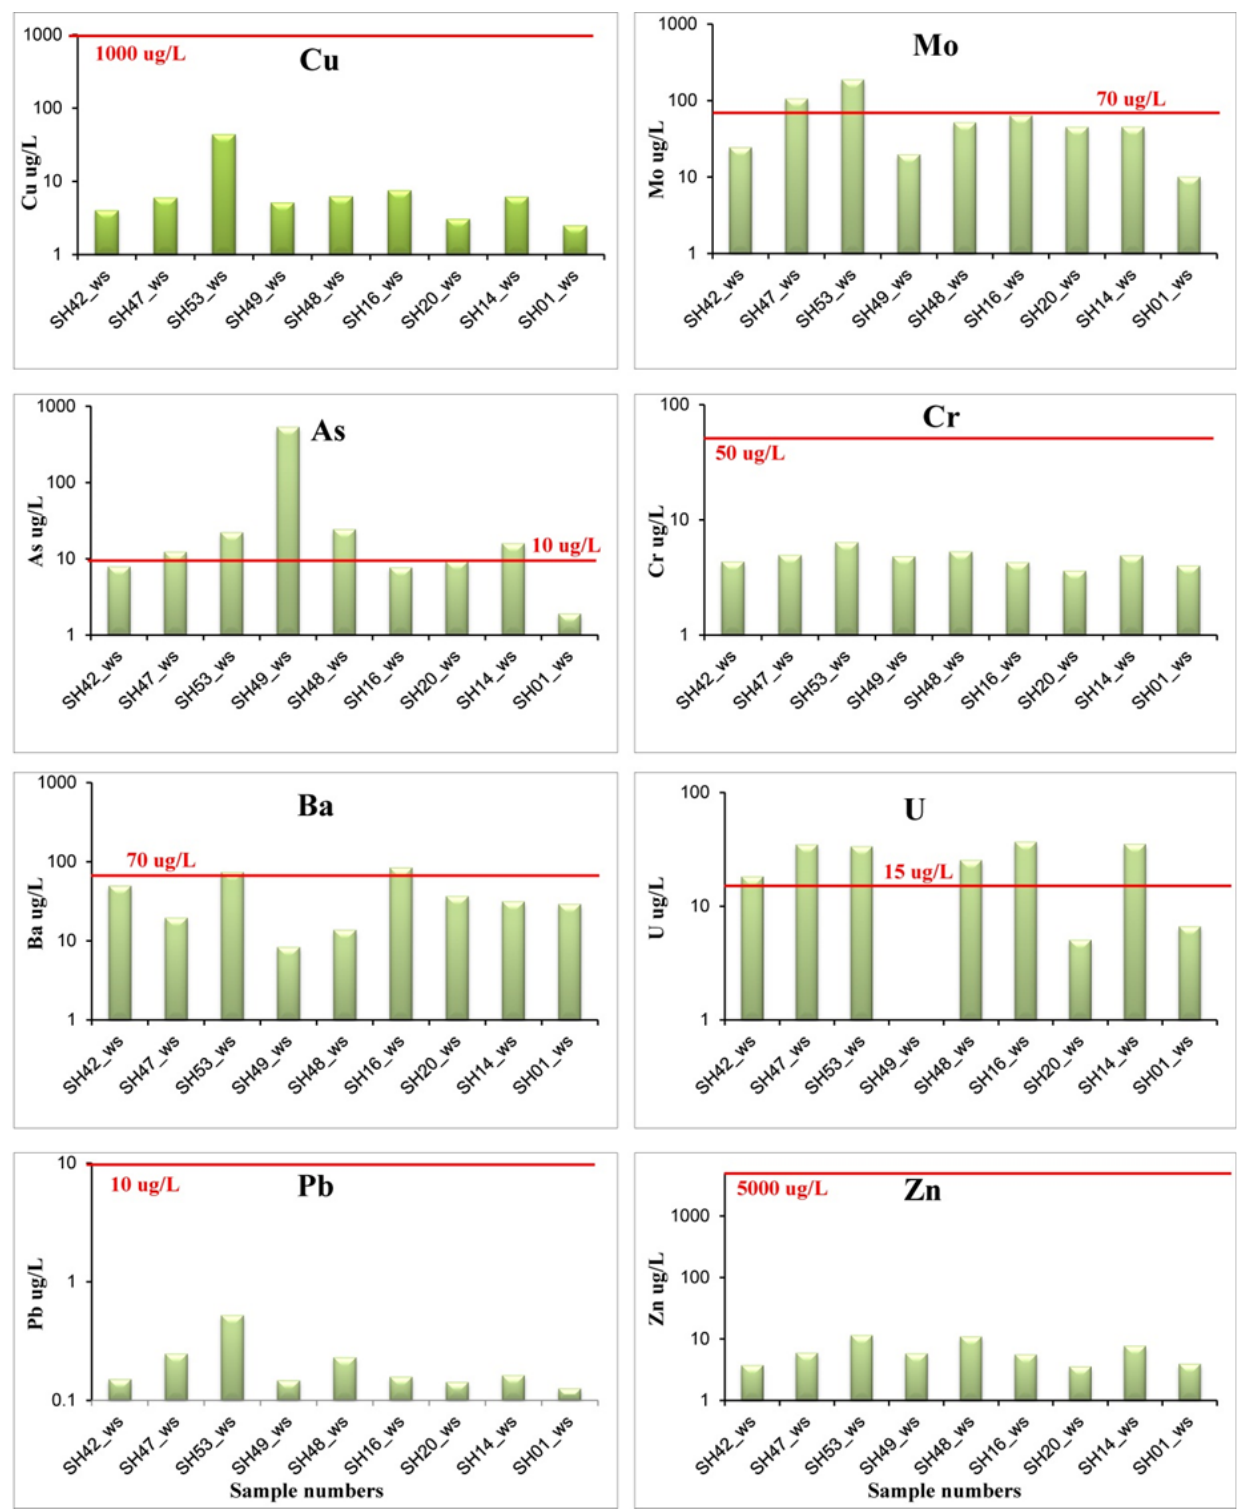
Fig. 7. Comparison of the drinking water standard of Mongolia with a heavy metal content of water samples from the wells in the Shuteen area. The red line shows the permissible limit of drinking water (Batkhishig et al.,